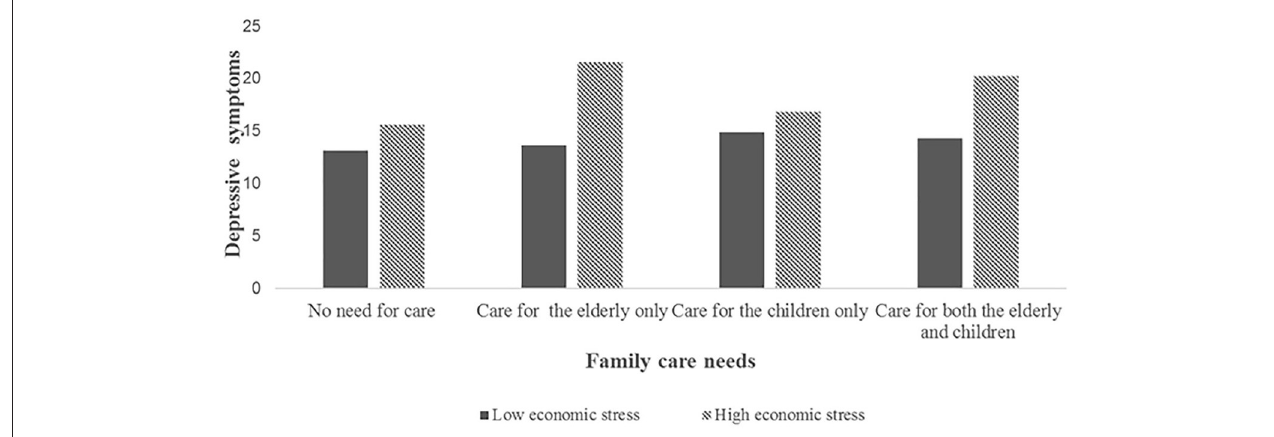
FIGURE 4 | The interaction effect of family care needs and economic stress on depressive symptoms in the rural